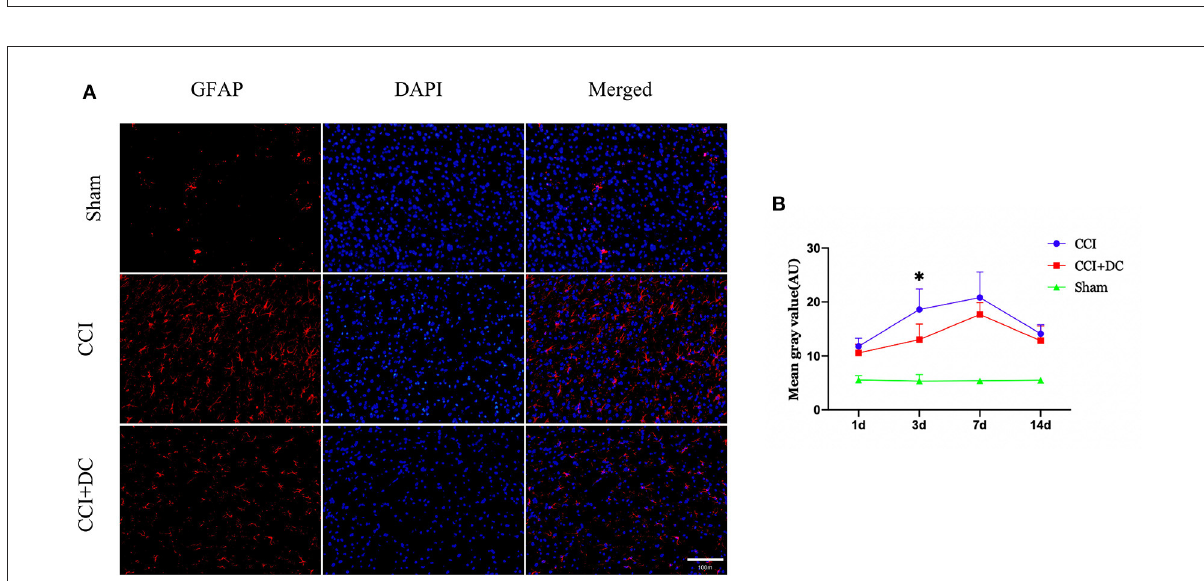
FIGURE11 Effect on peri-contusional cortex astrocytes. (A) The expression of astrocytes in different groups on the 3rd day after brain injury. (B) On day 3 after CCI, the expression of microglia in the cortex of the CCI + DC group was significantly lower than that of the CCI group, and the expression of was statistically different from that in the CCI group ( n = 6/group/time points, * P < 0.05, vs. CCI group).